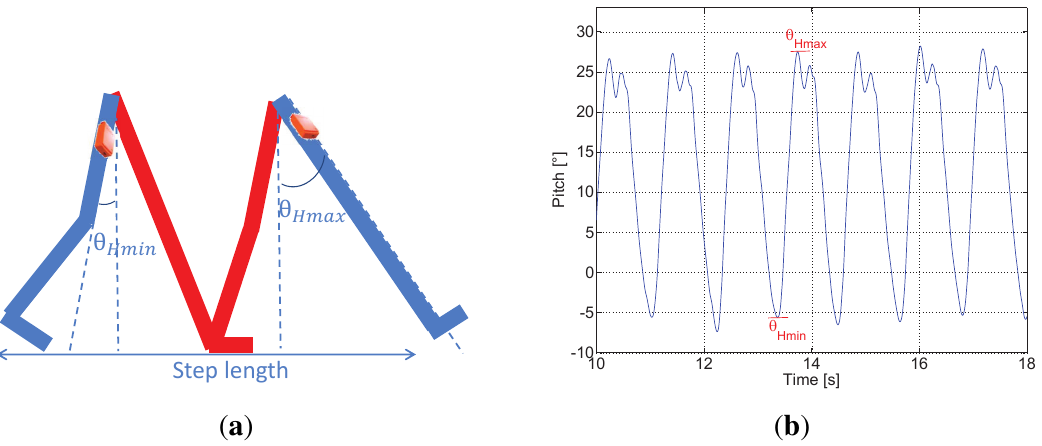
Figure 2. Pitch angle representation in schema and estimated signal. ( a ) Representation of the legs during a step. A step is completed every time the leg which has the sensor, in this case the blue one, hits the floor; ( b ) The blue line represents the pitch angle estimation during a walk. In this figure, seven steps are